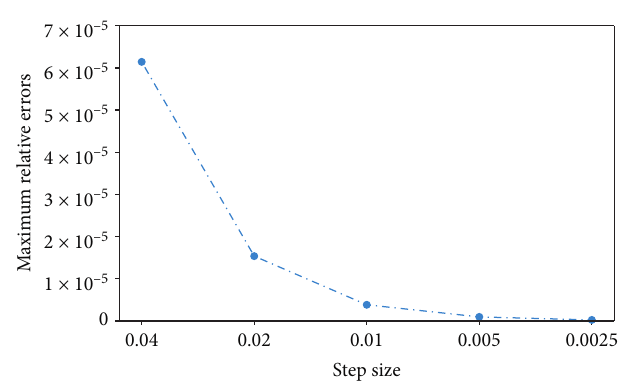
Figure 2: Maximum relative errors for decreasing step size.